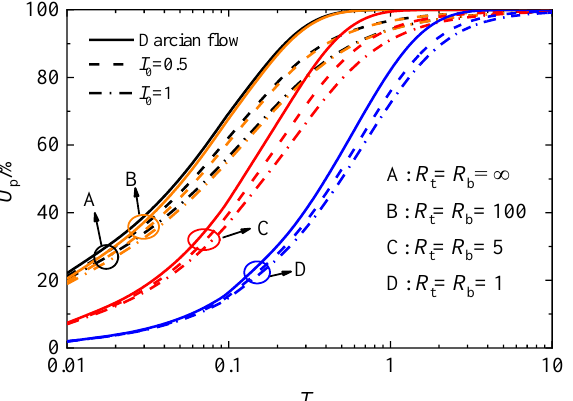
Figure 9. The influence of I 0 on the average degrees of consolidation under a single-side impeded drainage boundary.